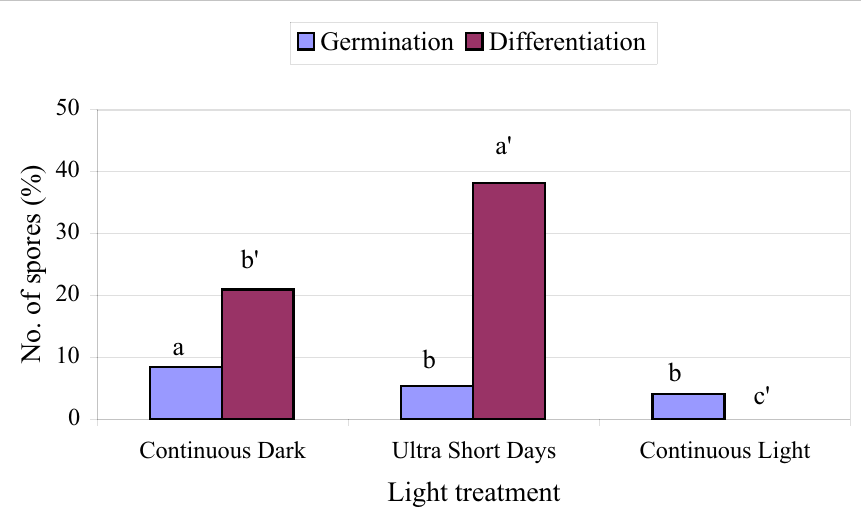
Fig. 4. Effect of light on the ratio of teliospore germination and basidium differentiation of Pileolaria terebinthi . Bars with the same letter(s) are not significantly different ( P